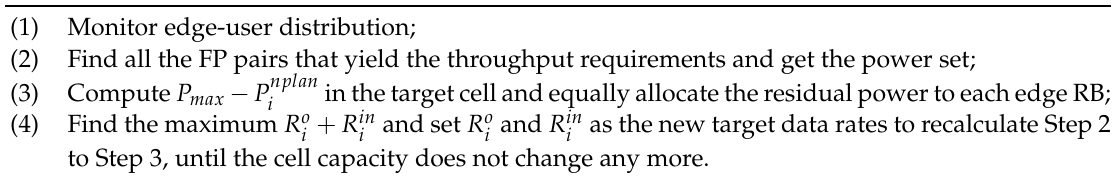
Algorithm 1. Single-cell Resource Allocation Solution of